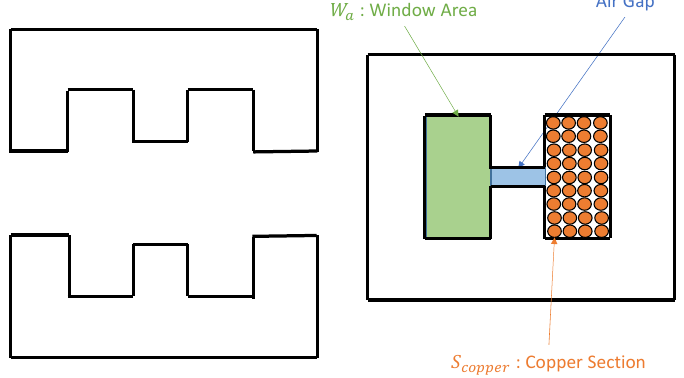
Figure 4. Magnetic core of the inductor.